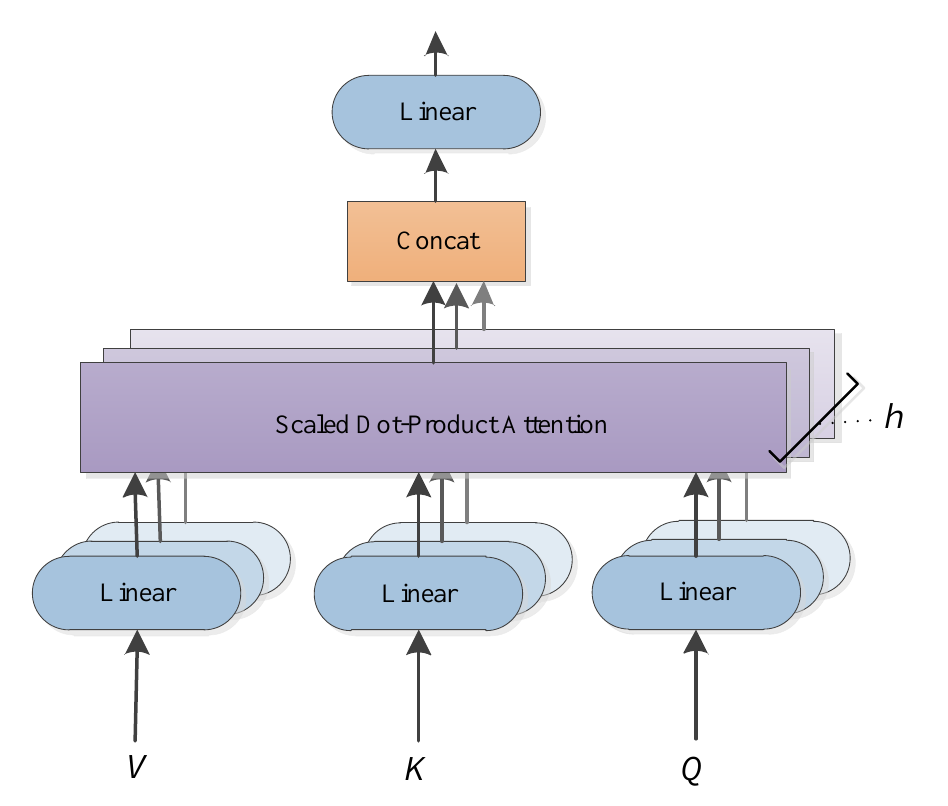
Figure 5. Multi-head attention